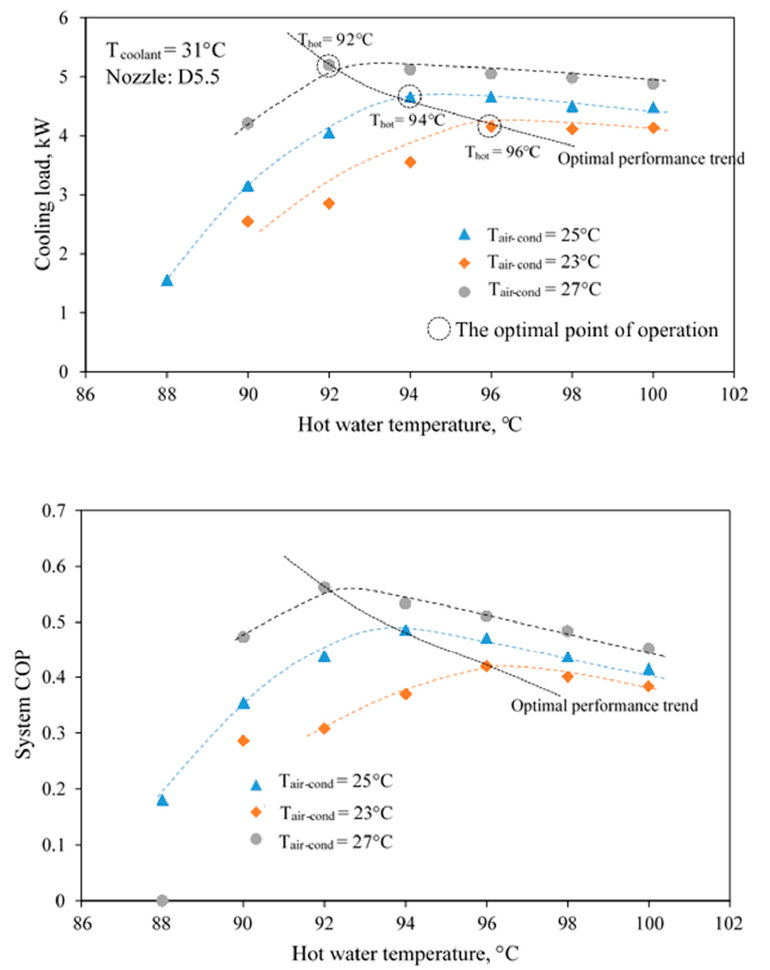
Figure 10 . The cooling load and system against T hot influenced by the air-conditioned temperatures . Figure 10. The cooling load and system against T hot influenced by the air-conditioned It is seen that an increase in the T air-cond requires a lower T hot to produce the best per- formance. At the optimal operation, the cooling load and system COP increase when the T air-cond is increased. The reason is that at a higher T air-cond , the evaporating pressure, which